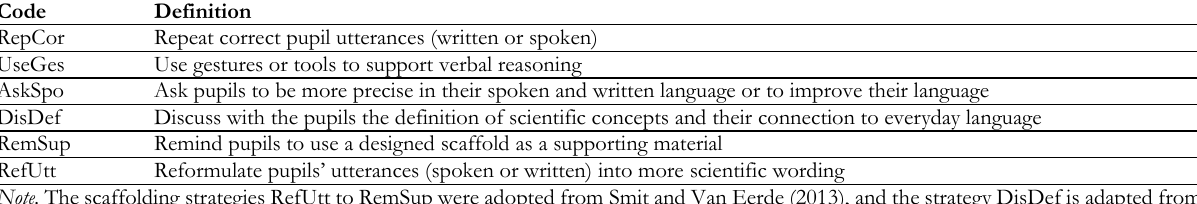
Table 3. Coding scheme of the scaffolding strategies